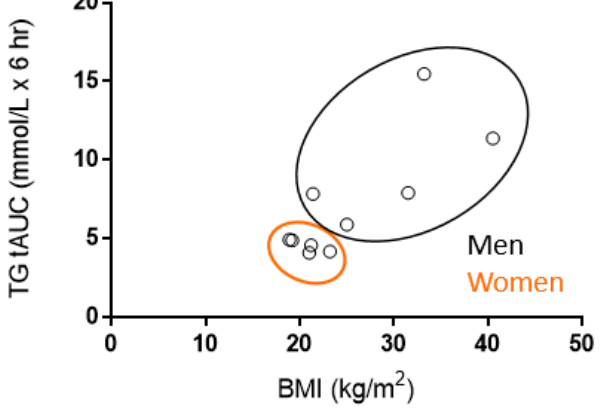
Figure 6. Correlation between TG tAUC and BMI. Data are means of TG tAUC for each participant (averaged across the four meal trials) and BMI (kg/m 2 ) value for each individual participant. There was a significant positive correlation between BMI and TG tAUC ( r = 0.79, R 2 = 0.63, p = 0.006). BMI, body mass index; TG tAUC, triglycerides total area under the curve.